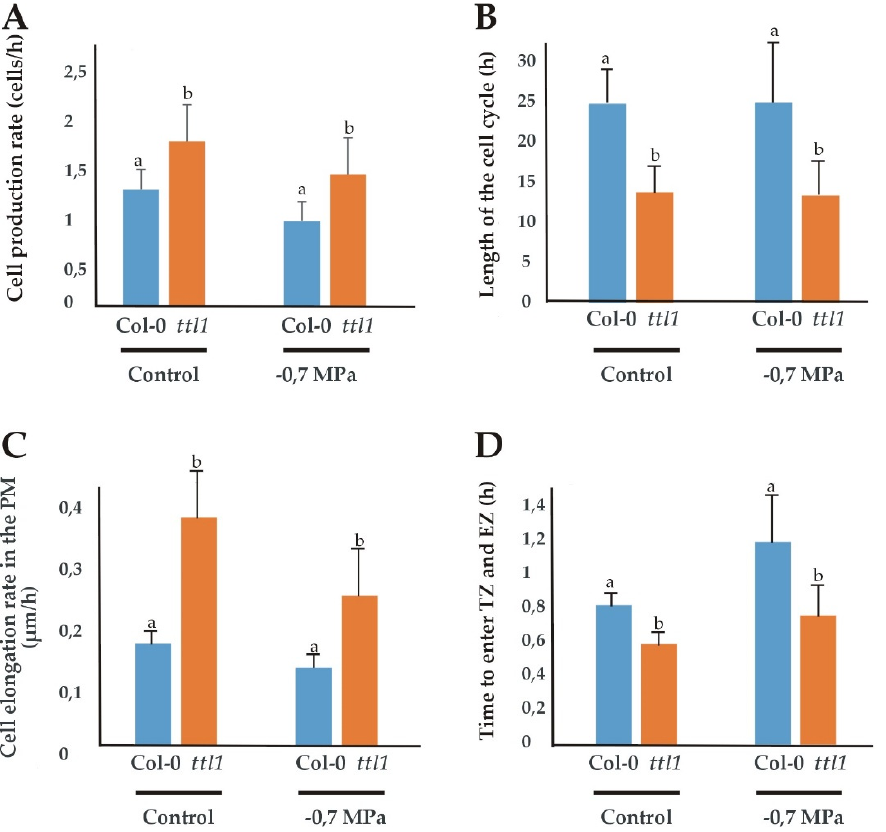
Figure 3. Growth parameters in the PM of Col-0 and ttl1 roots grown in control and osmotic stress conditions. The figure shows the cell production rate (cells/h) ( A ); the length of the cell cycle (h) ( B ); the cell elongation rate (µm/h) ( C ) and the time to enter the transition zone (TZ) and elongation zone (EZ) ( D ) for Col-0 and ttl1 grown during 7 days in control and − 0.7 MPa osmotic stress conditions. Values are means ± standard deviation (SD). Different letters indicate statistically significant differences ( t Student p < 0.05; n = 10).